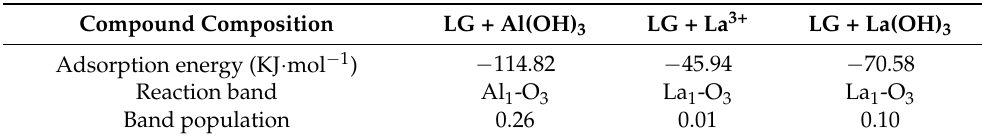
Table 4. The chemical interaction intensity of lauryl glucoside with aluminum ion and rare earth ion by DFT